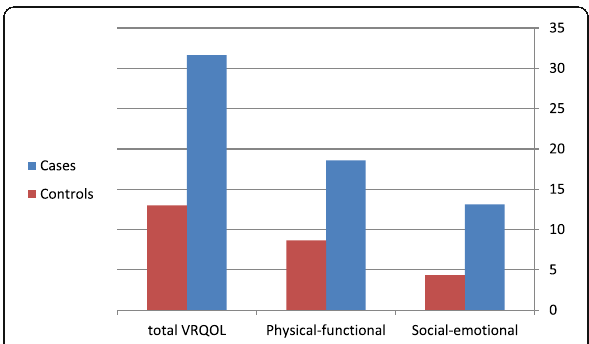
Fig. 1 Comparisons between the elderly with and without voice complaints in regards to subdomain means scores and total mean V-RQOL score